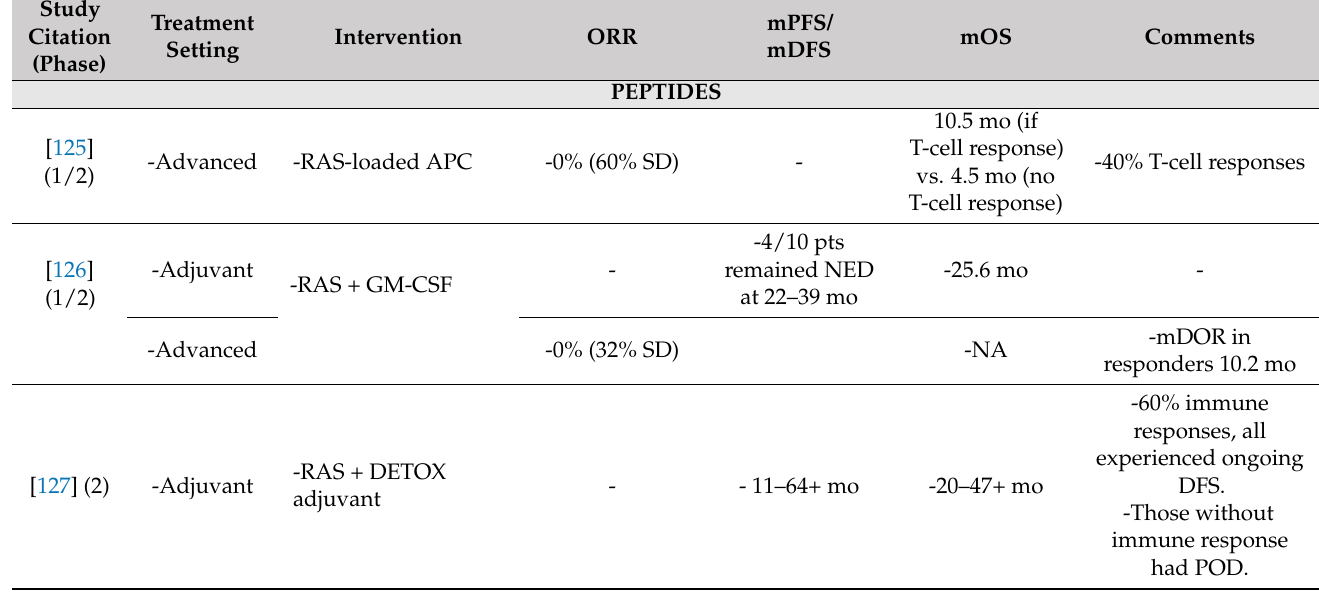
Table 4. Examples of Phase 2 or 3 Trials Using Vaccine Strategies in